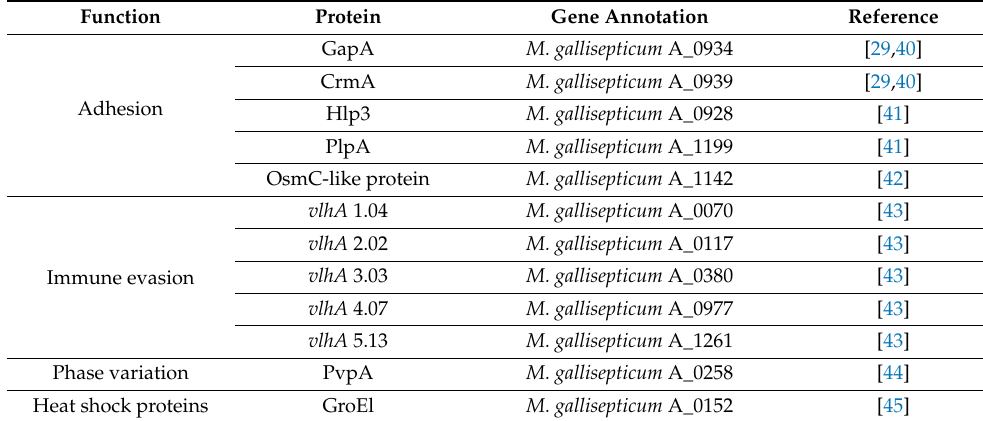
Table 1. Virulent proteins of M. gallisepticum involved in infection